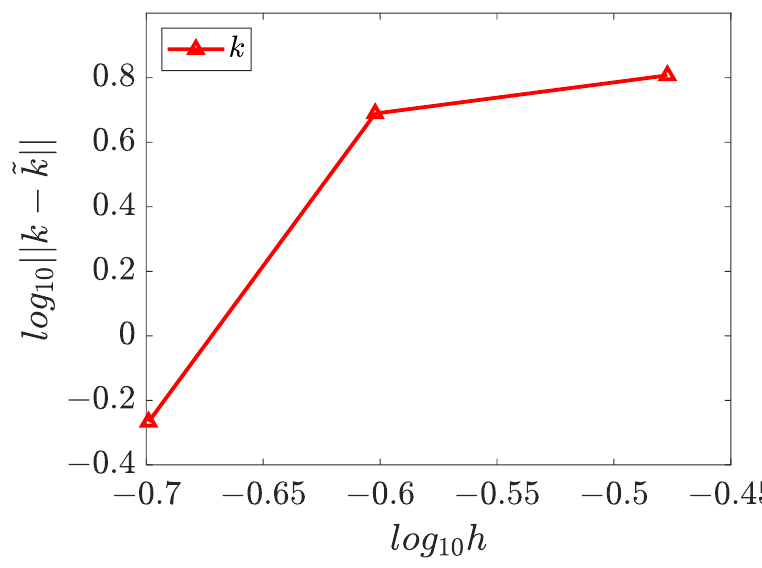
Figure 31. Convergence of wave number for the 3D parameter identification problem in spherical domain.